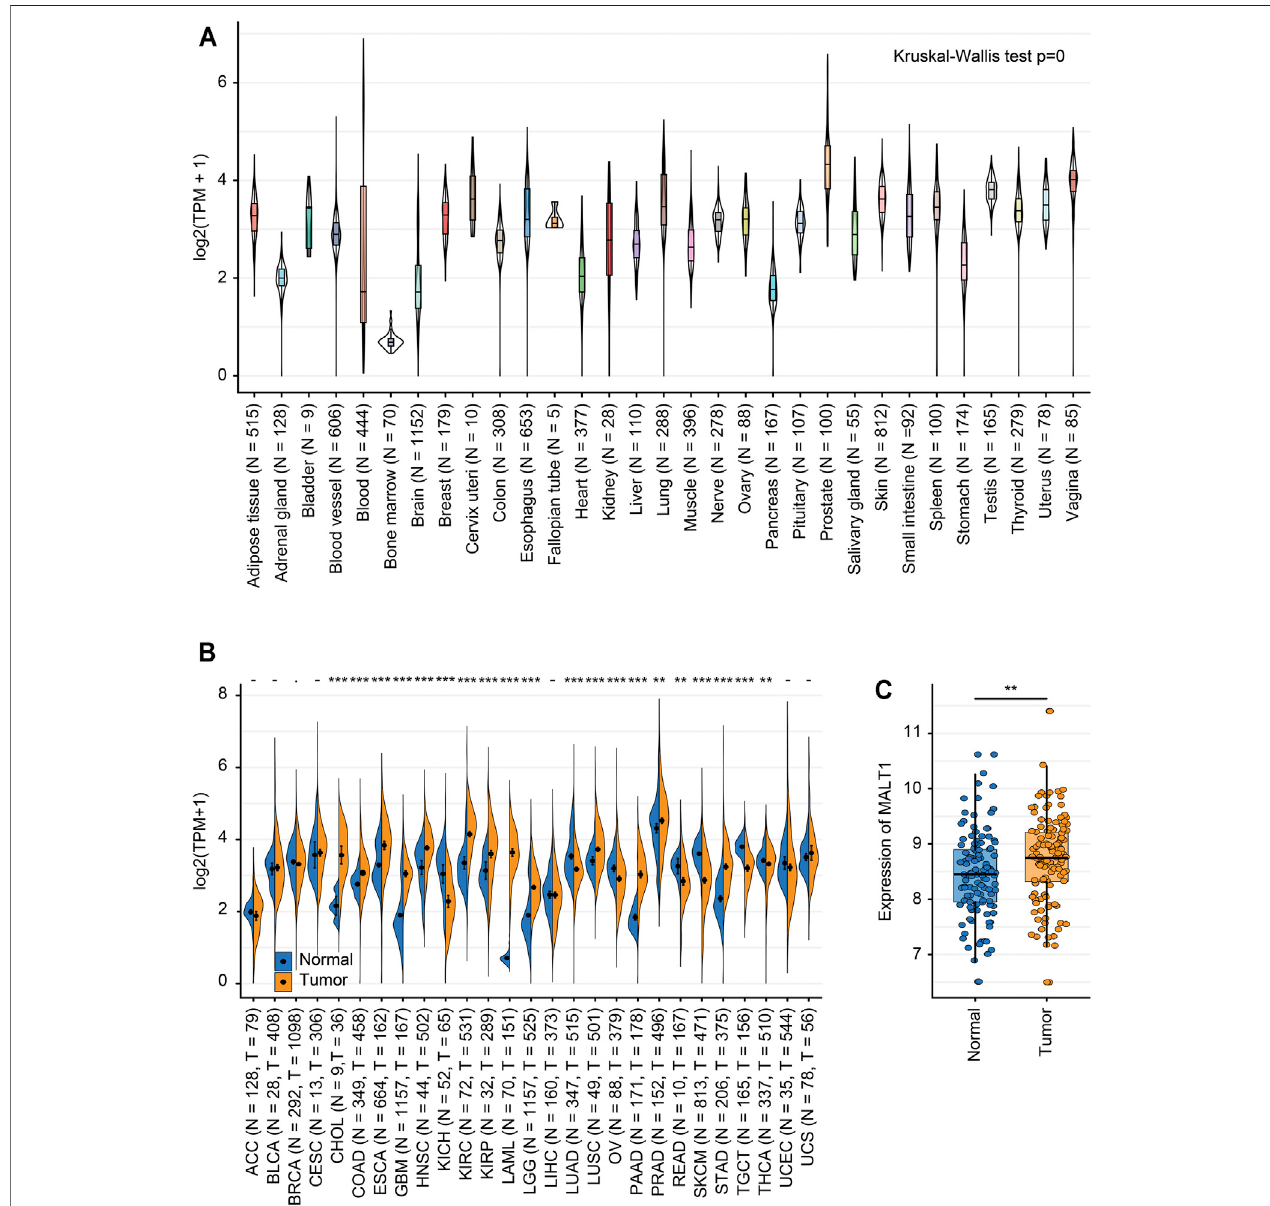
FIGURE 1 | Expression levels of MALT1 in tissues from different origins and tumors. (A) Normal mRNA expression levels of MALT1 in different tissues from the GTEx database. (B) mRNA expression difference in MALT1 among normal, peritumor and tumor samples, combining data from the TCGA and GTEx databases. (C) mRNA expression difference in MALT1 between normal and tumor samples, based on data from the GEO database. * indicates p < 0.05, ** indicates p < 0.01, *** indicates p < 0.001.